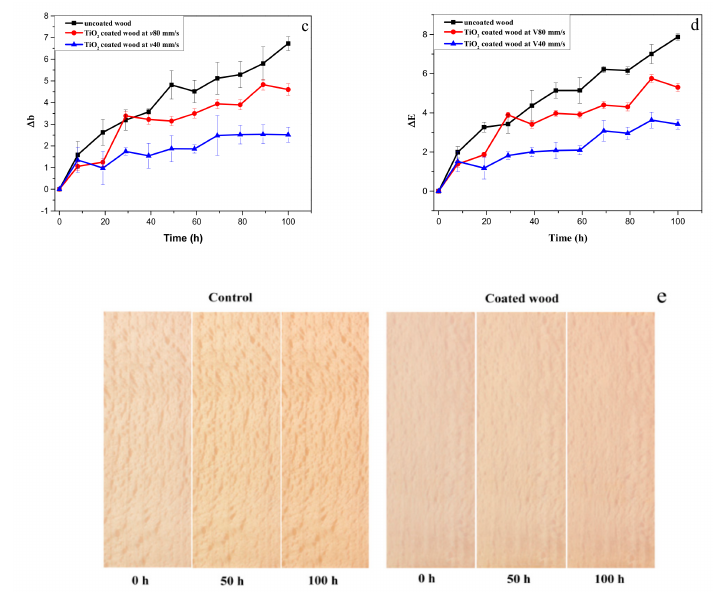
Figure 8. Colour change of coated and uncoated wood versus the irradiation time ( a ) lightness index change ∆ L , ( b ) red-green index change ∆ a , ( c ) yellow-blue index change ∆ b , ( d ) total color change ∆ E , and ( e ) optical images of the uncoated and coated wood before and after 50 and 100 h of